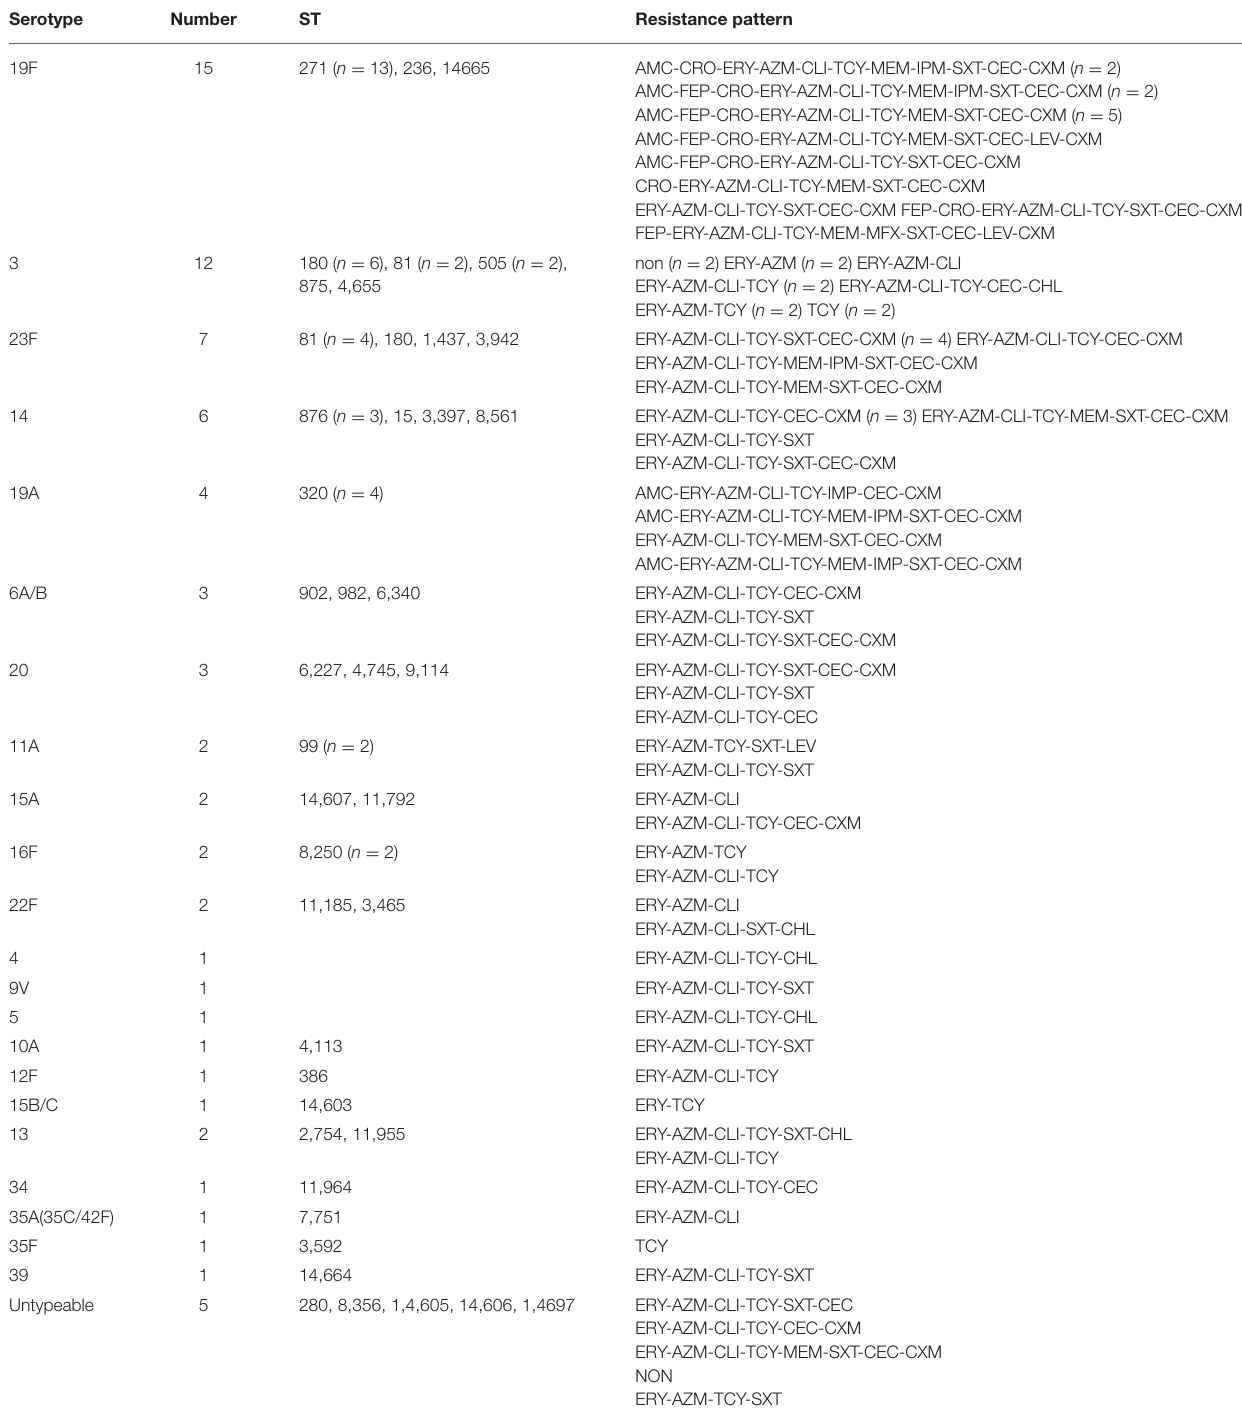
TABLE 5 | Resistance pattern of S. pneumoniae among different serotypes in Shanghai.